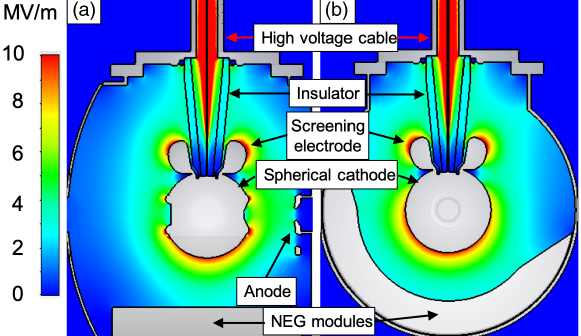
FIG. 6. Electrostatic model of the photogun at − 300 kV. The color represents the electric field strength in MV/m. (a) Side view cross section with the anode-cathode gap on the right. (b) Front view cross section looking from the anode. The NEG modules that line the bottom of the vacuum chamber could not be installed symmetrically due to the position of their electrical